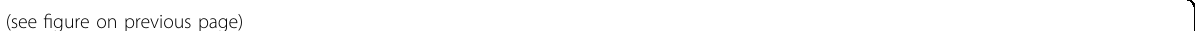
Fig. 5 FGF2 secreted by fi broblasts is involved in G-MDSC-mediated suppression of senescence and apoptosis. A KEGG pathway enrichment showing signaling pathways related to G-MDSCs. B Heatmap showing the expression levels of genes involved in signaling by the FGFR pathway in the MDSC-treated mice and the control mice. Red indicates a positive correlation, and blue indicates a negative correlation. C The mRNA levels of FGF2 in the fi broblasts and G-MDSCs cultured alone or cocultured with each other for 24 h analyzed by qPCR; n = 6 per group. D LVEF, LVDs, LV dp/ dTmax, and LV dp/dTmin of the mice administered G-MDSCs with or without BGJ398 (5 µm); n = 5 per group. E – H Senescent fi broblasts were cocultured with G-MDSCs for 24 h, and BGJ398 (5 µm) was used to neutralize FGF2. E The levels of β -galactosidase in fi broblasts analyzed by fl ow cytometry through C12FDG staining. Representative cytograms are shown on the left, and statistical data are shown on the right; n = 7 per group. F The mRNA levels of the senescence markers Cdkn2a and Cdkn2b in fi broblasts; n = 8 per group. G Representative images and statistical data of senescent fi broblasts using X-gal staining. Red arrows represent X-Gal + fi broblasts; n = 7 per group. Scale bars, 50 μ m. H Representative fl ow cytometric pro fi le and statistical data of fi broblast apoptosis through Annexin V-FITC and PI staining; n = 7 per group. The data are presented as the means ± SDs. The data are presented as the means ± SDs. Differences were determined by one-way ANOVA (more than 2 groups), and Tukey ’ s HSD post hoc test was performed. * P <